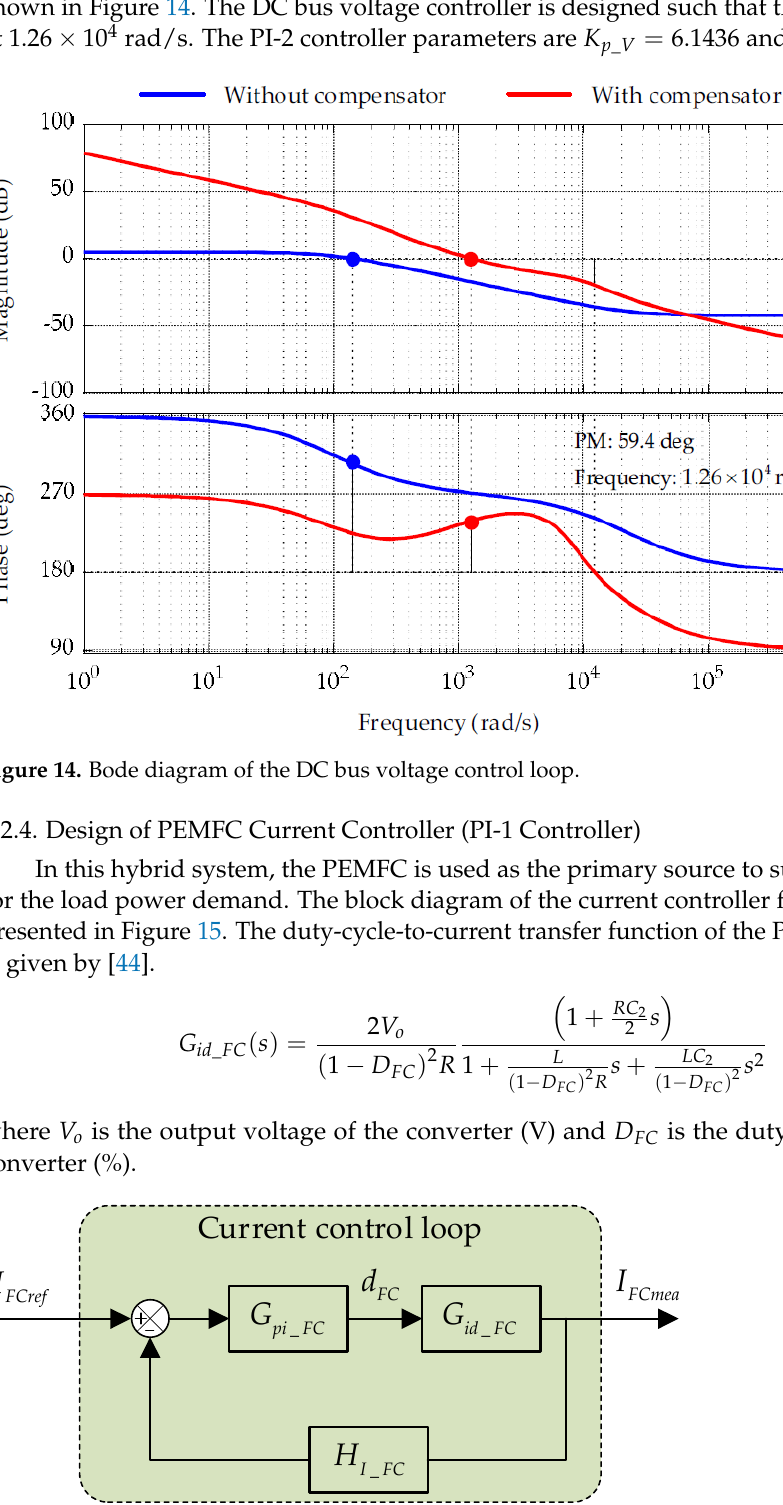
The Bode plot of the voltage control loop with and without the PI compensator is